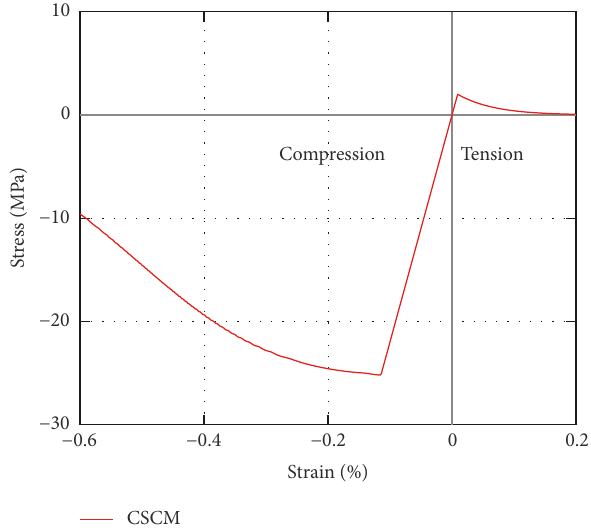
Figure 4: Stress-strain diagram for 25 MPa CSCM material model. Unconfined uniaxial tension and compression.